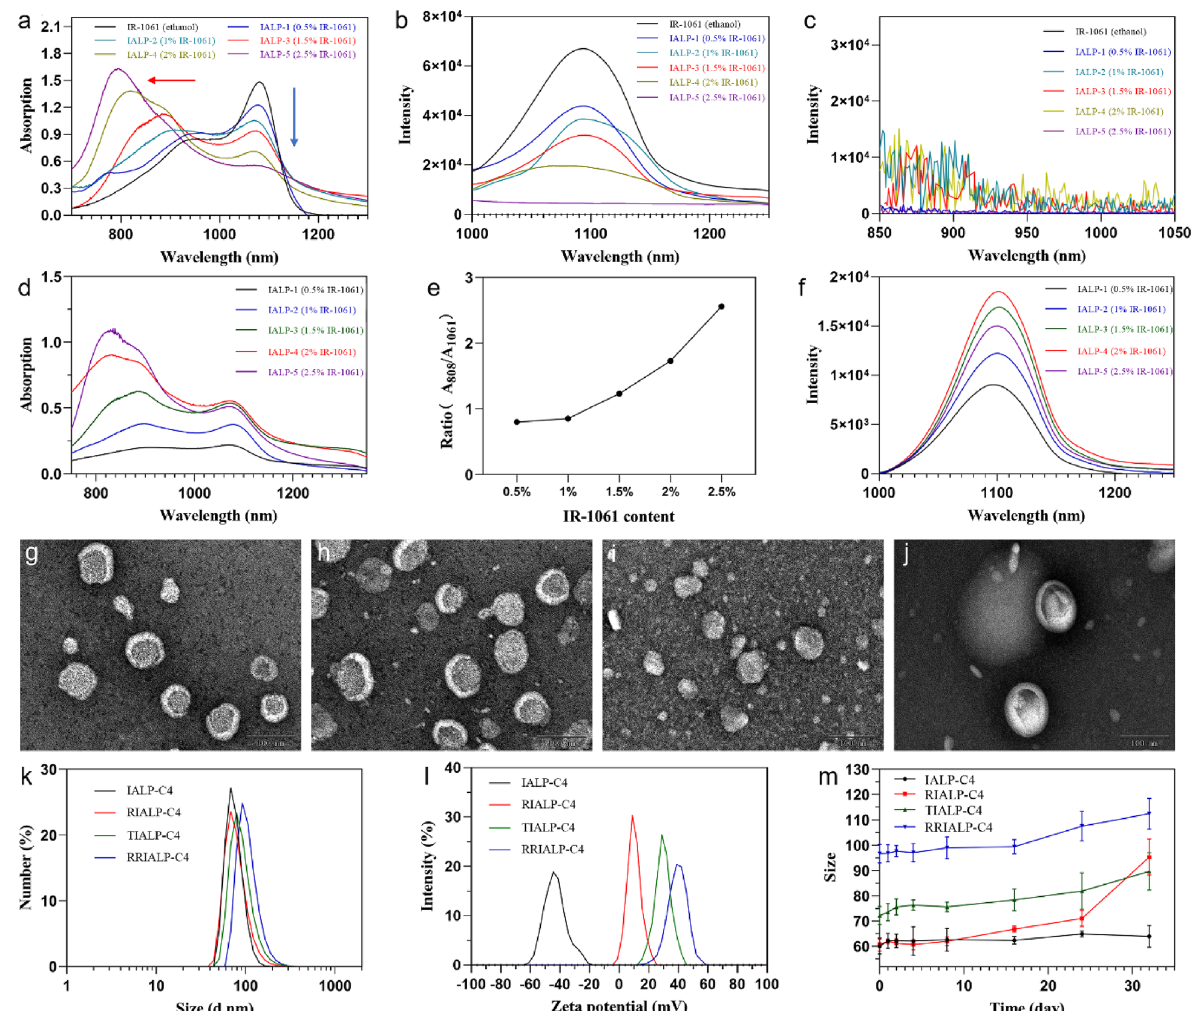
concentrations of phospholipid. e A 808 /A 1061 ratio of ALPs with different IR-1061 contents. f Fluorescence spectra of ALPs at 1061 nm excitation. g – j TEM images of IALP-C4, RIALP-C4, TIALP-C4 and RRIALP-C4. k , l Hydrodynamic size and zeta potentials of IALP-C4, RIALP-C4, TIALP-C4, and RRIALP-C4. m Size changes of liposomes placed at 4 °C for 30